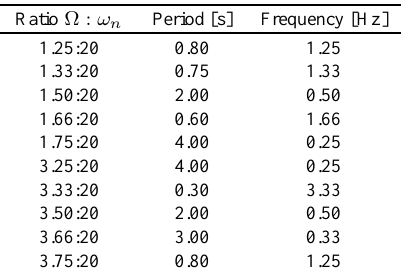
Table 3 Result of several simulations when Ω and ω